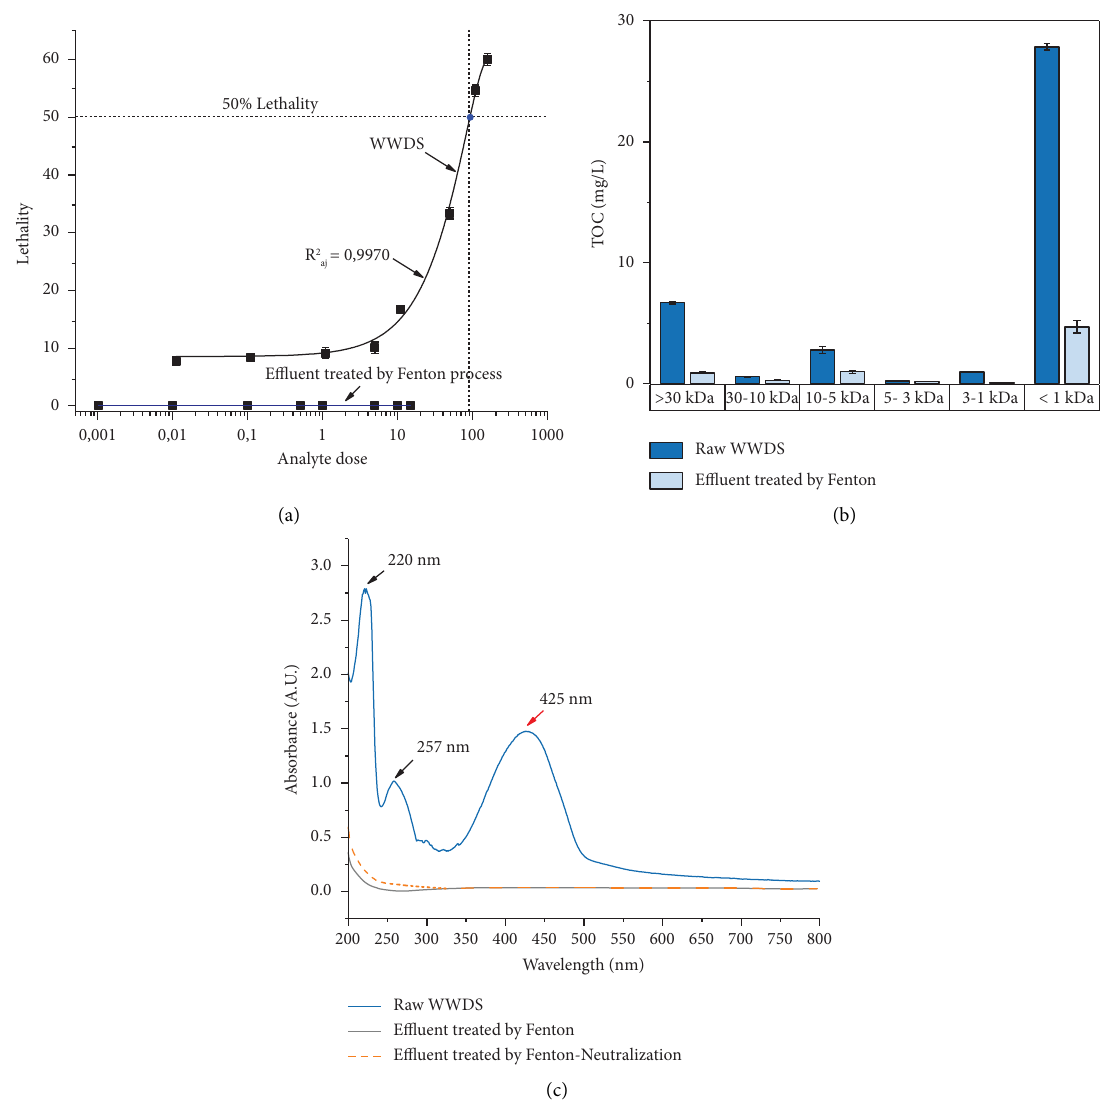
Figure 2: (a) Change in lethality for Artemia salina (24h) of raw (WWDS) and Fenton-treated efuent, (b) MWD analysis of raw WWDS and Fenton-treated efuent in terms of TOC, and (c) UV-Vis absorption spectra before and after the Fenton and Fenton-neutralization